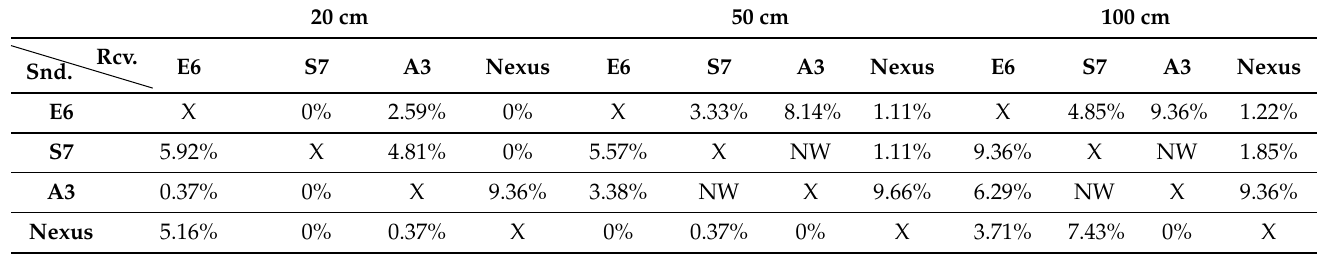
Table 5. BER for indoors experiments (16.7–20 KHz range).